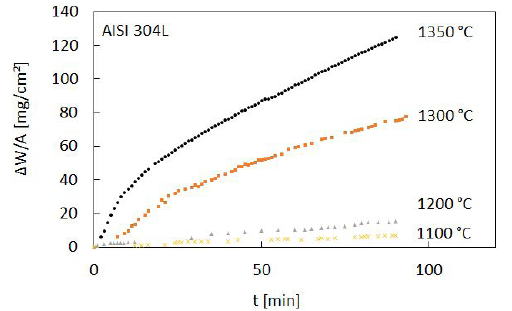
Figure 2. Evolution of the weight gain for AISI 304L at 1100 °C, 1200 °C, 1300 °C and 1350 °C in water.